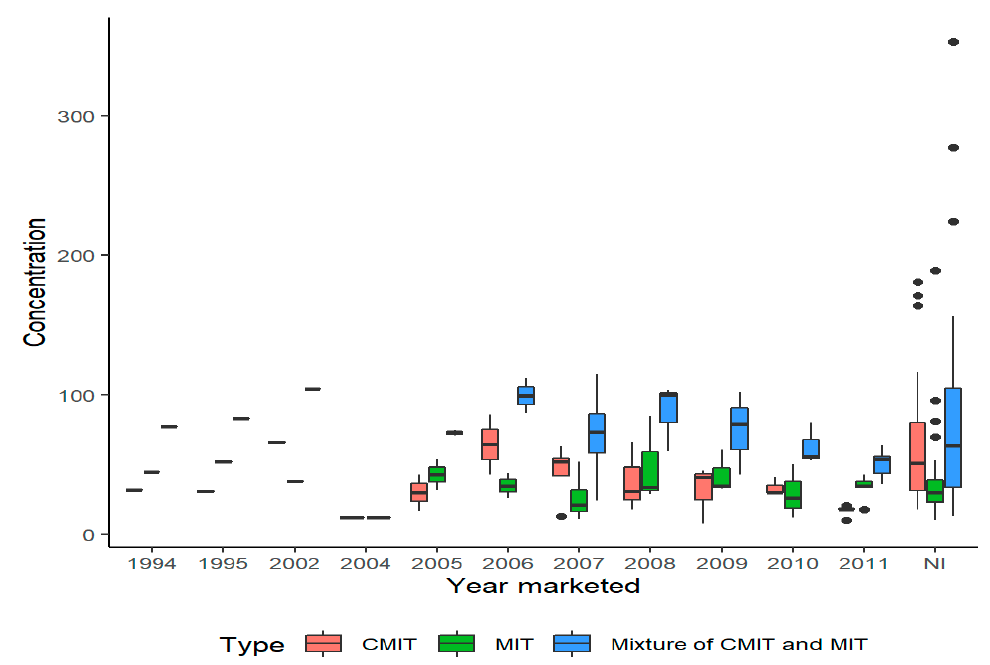
Figure 1. The levels of CMIT and MIT contained in the HD products by year marketed (CMIT, 5-chloro-2methylisothiazol-3(2 H )-one; MIT, 2-Methylisothiazol-3(2 H )-one).